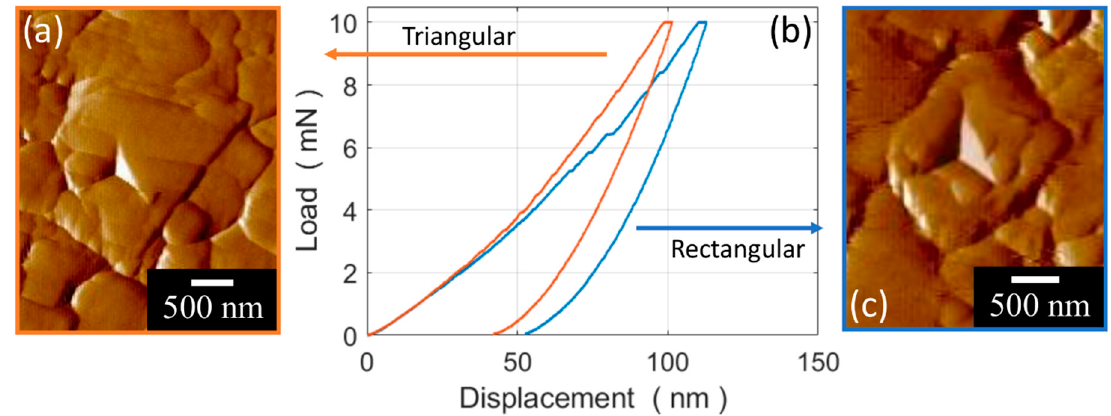
Figure 7. AFM force gradient forward scan of a typical nanoindentation imprint over ( a ) triangular and ( c ) rectangular WC particles, and ( b ) the inherent nanoindentation curves.